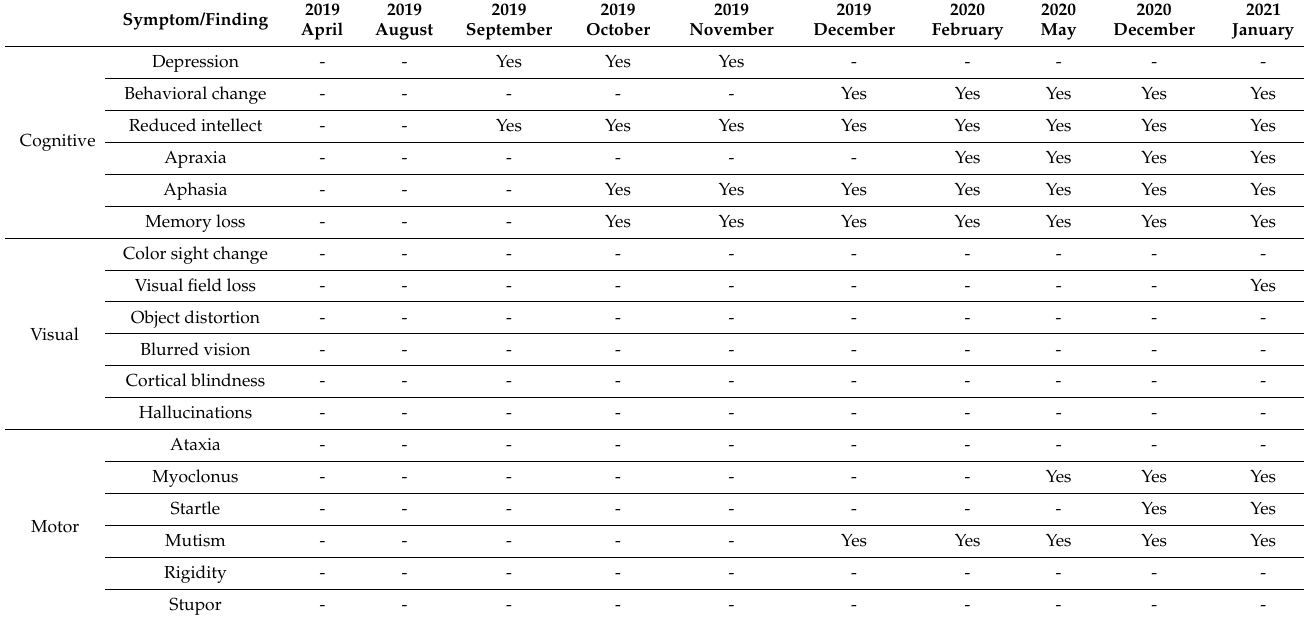
Table 1. Clinical symptoms progression since disease debut.